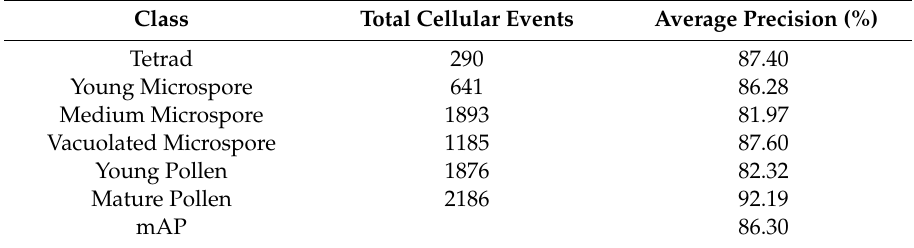
Table 2. Results of the precision in the model prediction for the di ff erent cell classes defined during the development of the eggplant microspore towards pollen grain. The mean average precision (mAP) of the algorithm is also